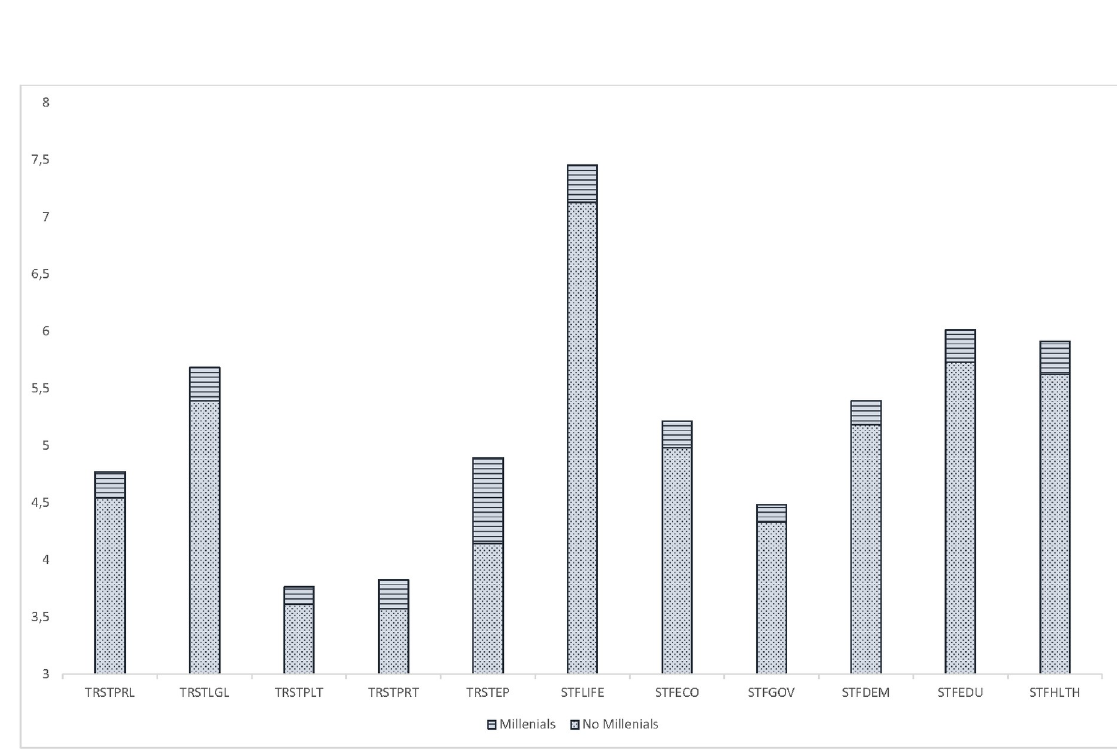
Fig 1. Comparison of mean values of institutional trust and satisfaction